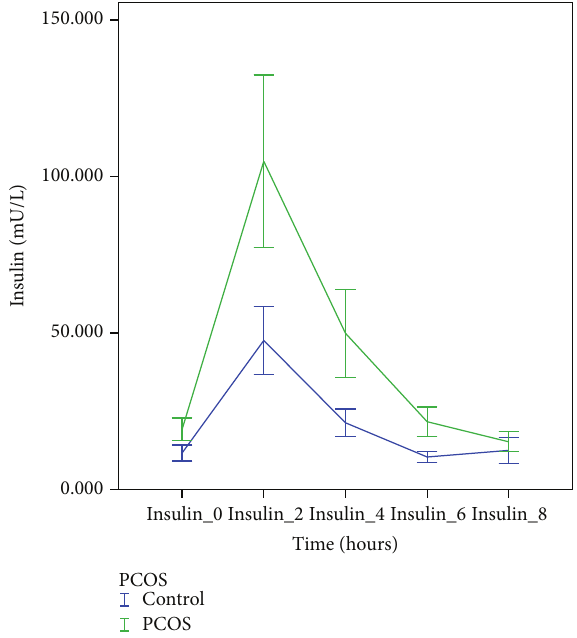
Figure 4: Postprandial insulin response in PCOS and control subjects.